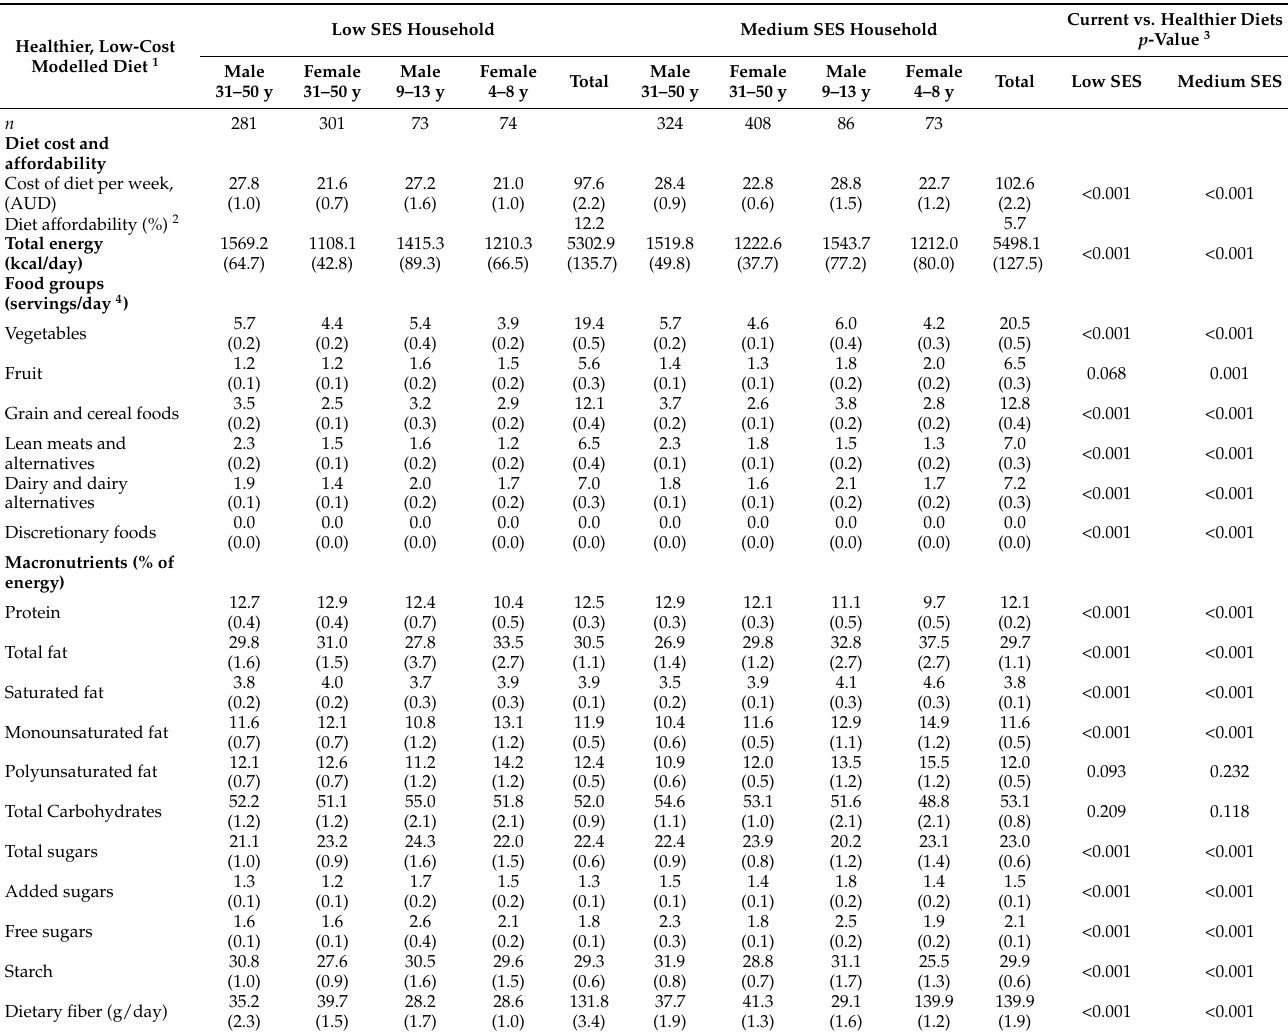
Table 5. The theoretical modelled healthier, low-cost diet for each member of the reference household, for both low and medium SES